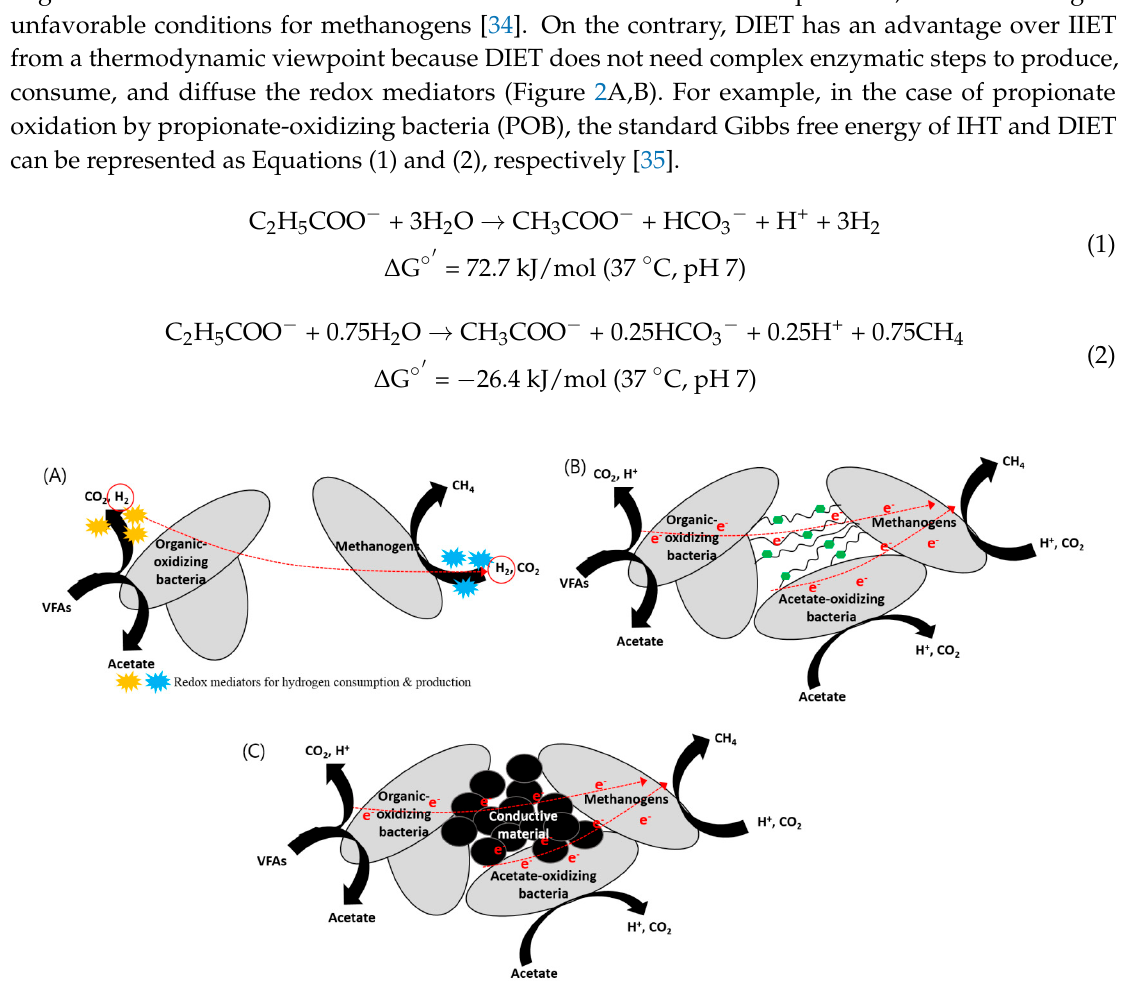
Figure 2. Mechanisms of ( A ) indirect interspecies electron transfer (IIET) via hydrogen, ( B ) biological direct interspecies electron transfer (DIET), and ( C ) conductive material-mediated DIET.